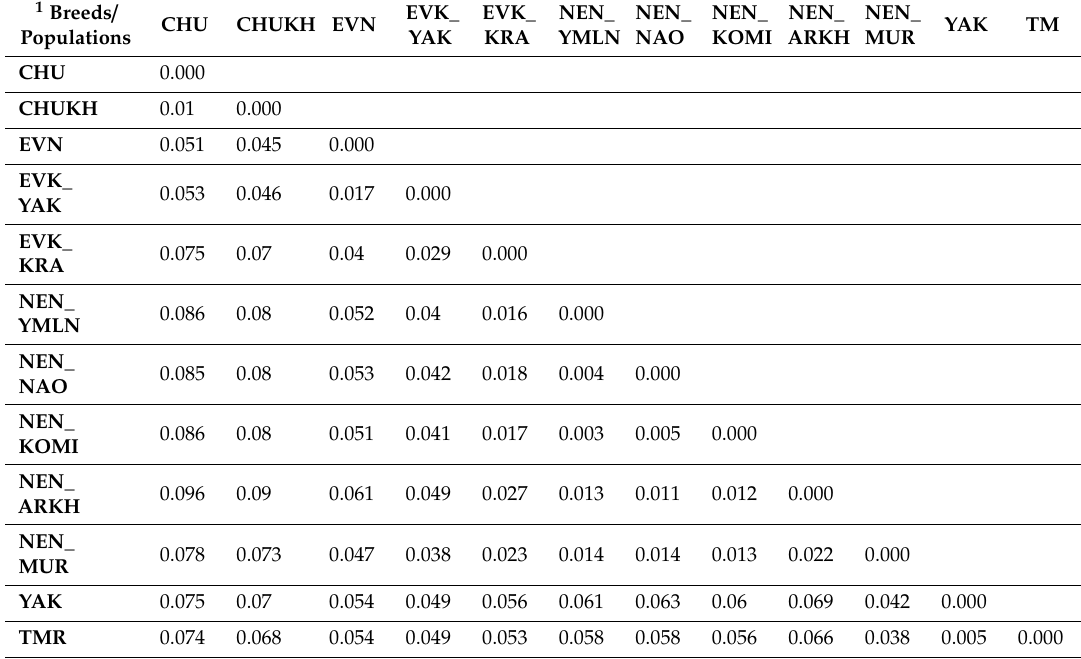
Table 2. Genetic di ff erentiation of domestic reindeer breeds measured by F ST